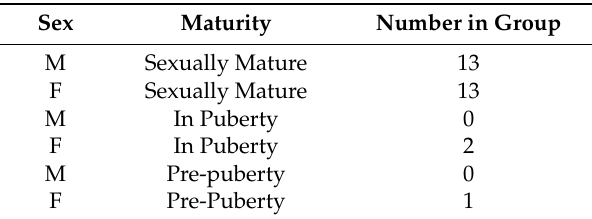
Table 3. Orcas with reported